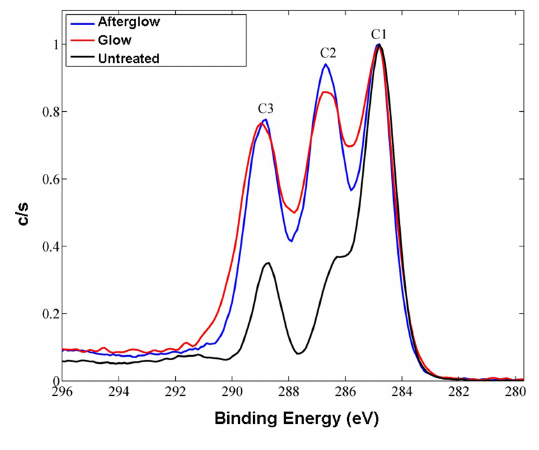
Figure 2 : High resolution C1s peaks for an untreated sample and samples treated in plasma and afterglow for 10 s.